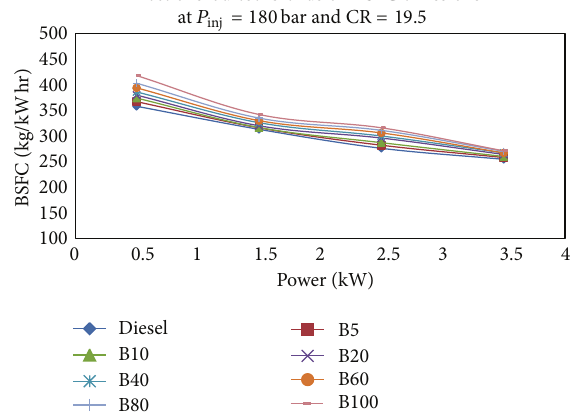
Figure 21: Variation in CO for various biodiesel blends at 𝑃 200 bar and CR 19.5.